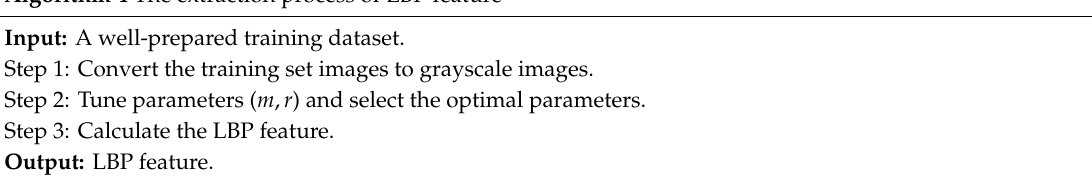
Algorithm 4 The extraction process of LBP